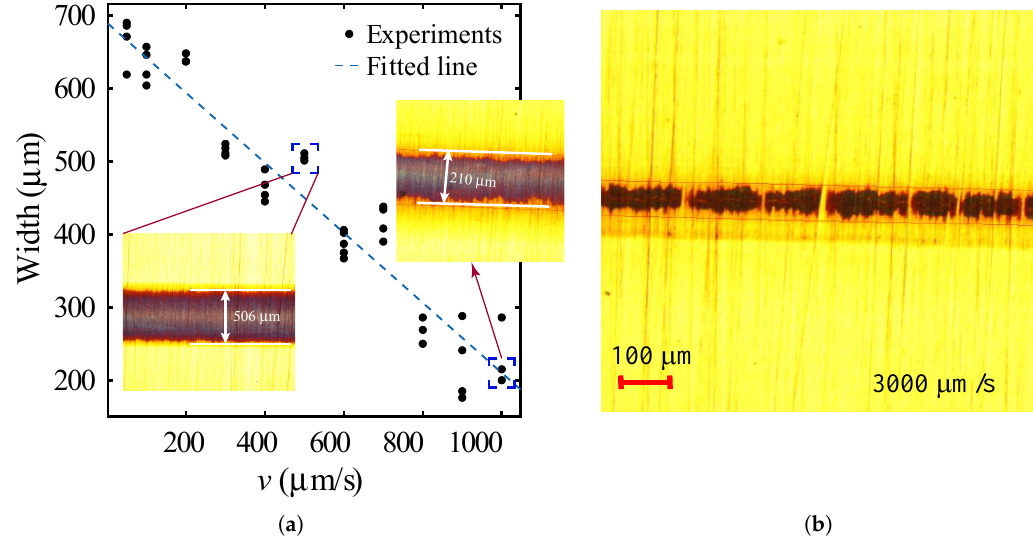
Figure 5. ( a ) Printed line width as a function of printing speed. ( b ) An optical microscope image of the printed line with the speed of 3000 µm/s.